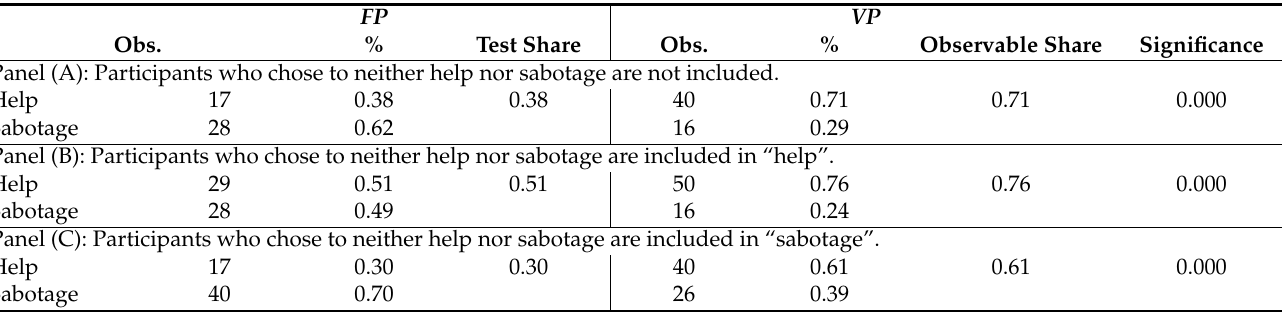
Table 4. Binomial